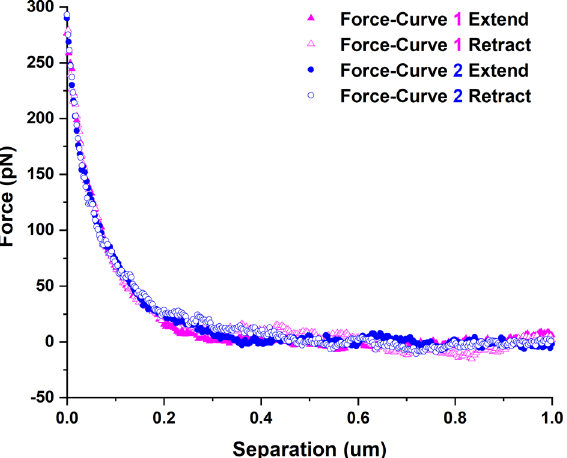
Figure 7. Two indentation force-curves at the same location of the lehfilcon A CL surface indicating the perfectly elastic nature of the lens